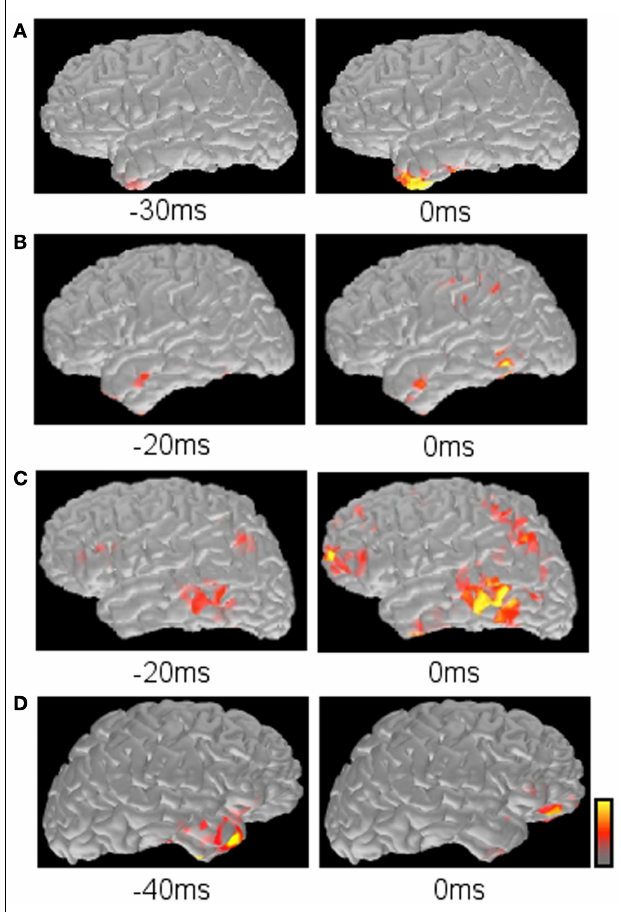
FIGURE 6 |Typical propagation patterns suggested by MNE maps . (A) Restricted onset and restricted peak activation in the left anterior temporal lobe. (B) Restricted onset in the left anterior temporal lobe and widespread peak in the left posterior temporal and parietal lobes. (C) Widespread onset and widespread peak in the left frontal, temporal, and parietal lobes. (D) Restricted early activation in the right anterior temporal lobe and late activation in the right inferior frontal